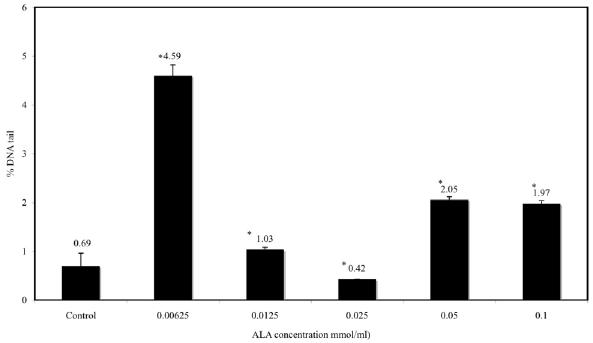
Figure 3 - Percentage of tail DNA (N=31) against a range of ALA concen- tration (0, 0.00625, 0.0125, 0.025, 0.05 and 0.1mmol/ml). Percentage of tail DNA was done using Comet assay imaging software (CASP version 2). Kruskal Wallis ANOVA was used to determine significant differences between ALA concentrations and percentage of DNA tail. There is a sig- nificant differences between the range of concentration compared to control group.